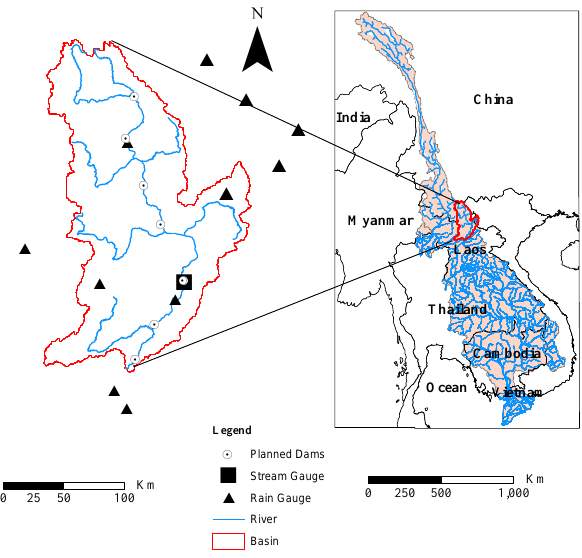
Fig. 1. Location of the study area, stream gauge, rainfall gauges used for interpolating spatial rainfall and location of planned